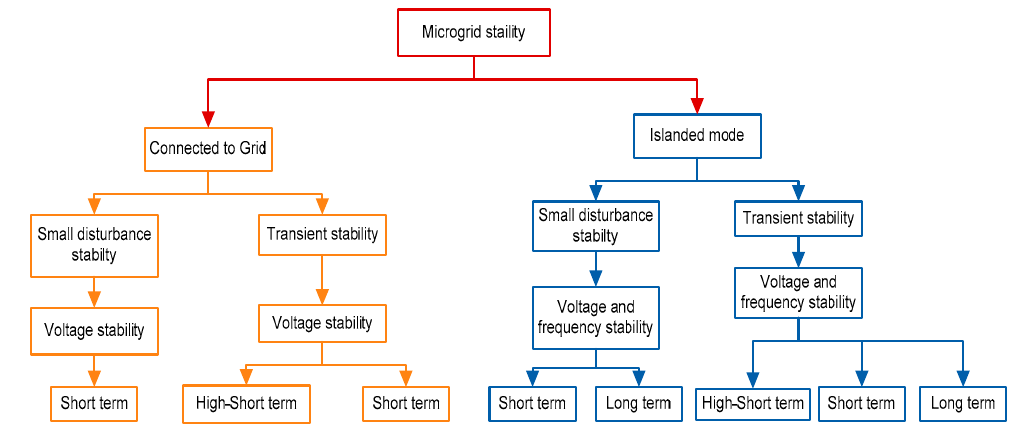
Figure 2. Microgrid stability.